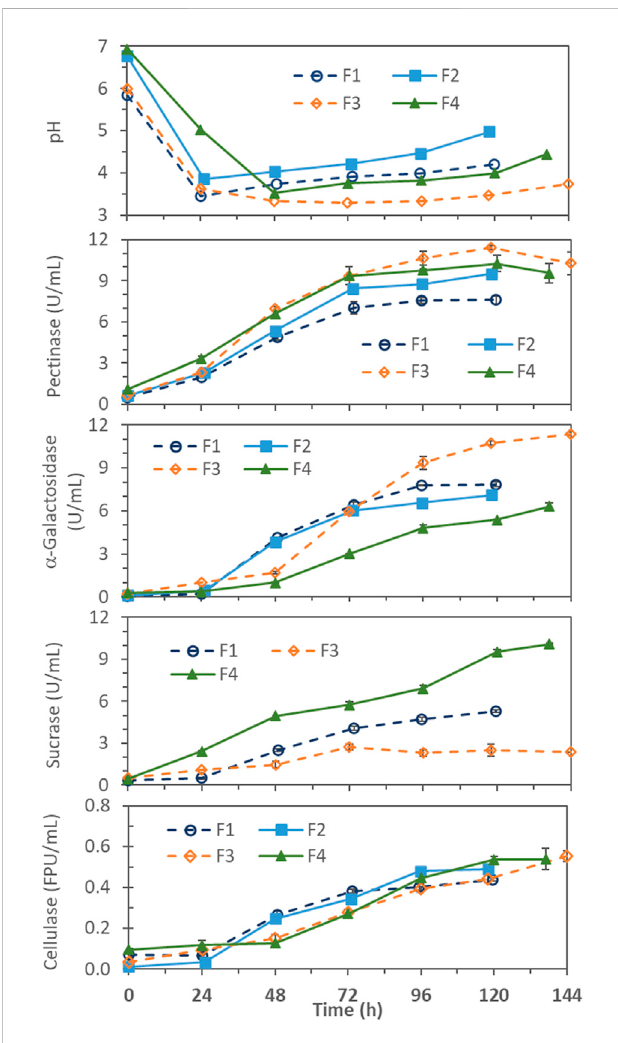
FIGURE 1 pH and enzyme production pro fi les in pH-uncontrolled batch fermentations with different soybean hull (SH) and non-hull N-sources (N)concentrationsandinitialpH;F1=2xSH,2xN,pH6;F2=2xSH,2xN, pH 7; F3 = 5x SH, 2x N, pH 6; and F4 = 5x SH, 5x N, pH 7. 1x SH = 20 g/L soybean hull and 1x N = 1.4 g/L (NH 4 )2SO 4 , 1.0 g/L proteose peptone, and .3 g/L